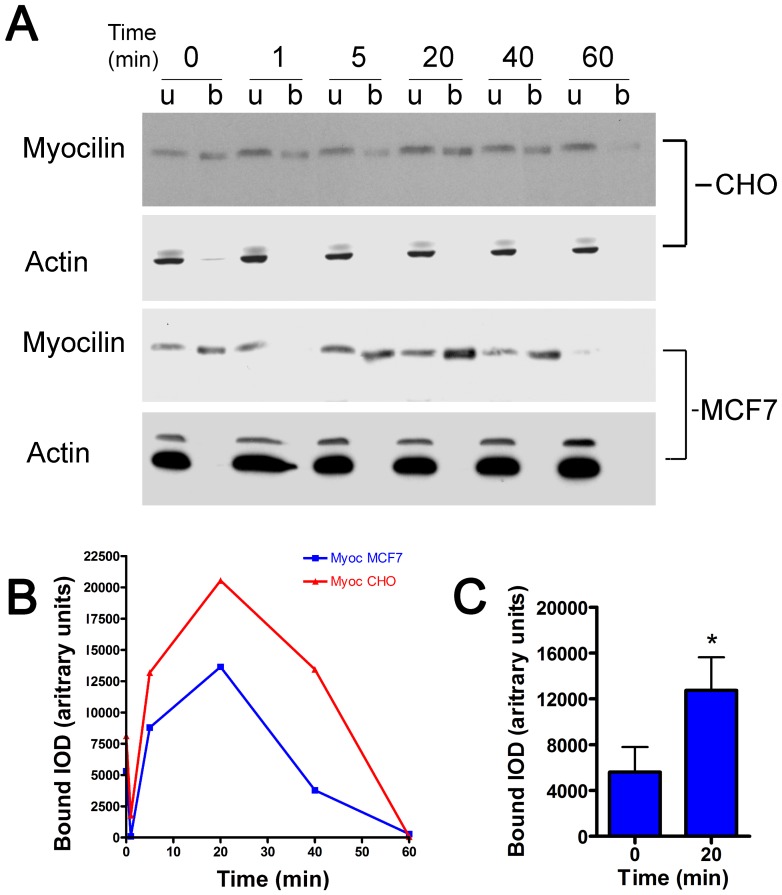
Time-course of ligand-dependent myocilin recruitment to cell-surface membranes containing GPR-143.After labeling cell surface proteins with biotin, CHO and MCF7 cells stably expressing MYOC and GPR143 were stimulated with l-DOPA, then proteins were harvested at the times illustrated. (A). Shown are representative western blots of cell lysates subjected to strepavidin chromatography. Proteins in bound (b) and unbound (u) fractions were probed for myocilin (MYOC) and actin abundance. (B). Specific bands from blots were analyzed using ImageJ to quantify band intensity and kinetic results of bound fraction for all three proteins analyzed for an individual experiment is shown. Results are representative of 4 experiments for each cell type tested. The mean values of the bound MYOC at time zero and at 20 min are compared for the experiments in aggregate, and found to be significantly different (* p<0.05).